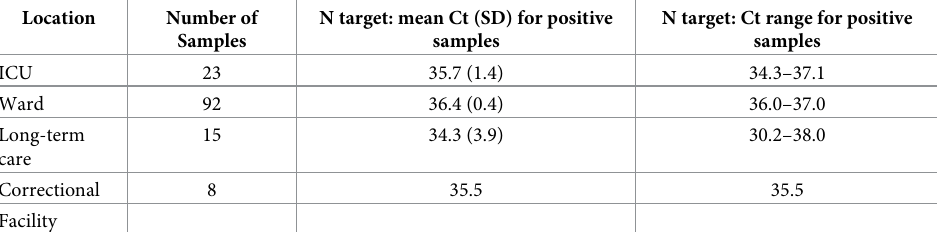
Table 3. Positive SARS-CoV-2 RNA samples by room type, including Ct values for N target. Location